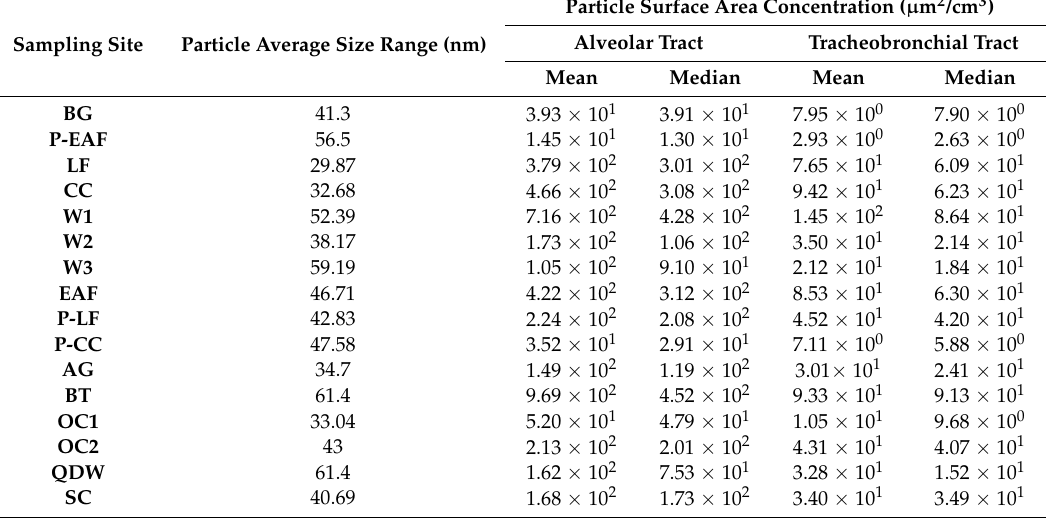
Table 2. Particle size range (average, nm), particle surface area concentration deposited in alveolar